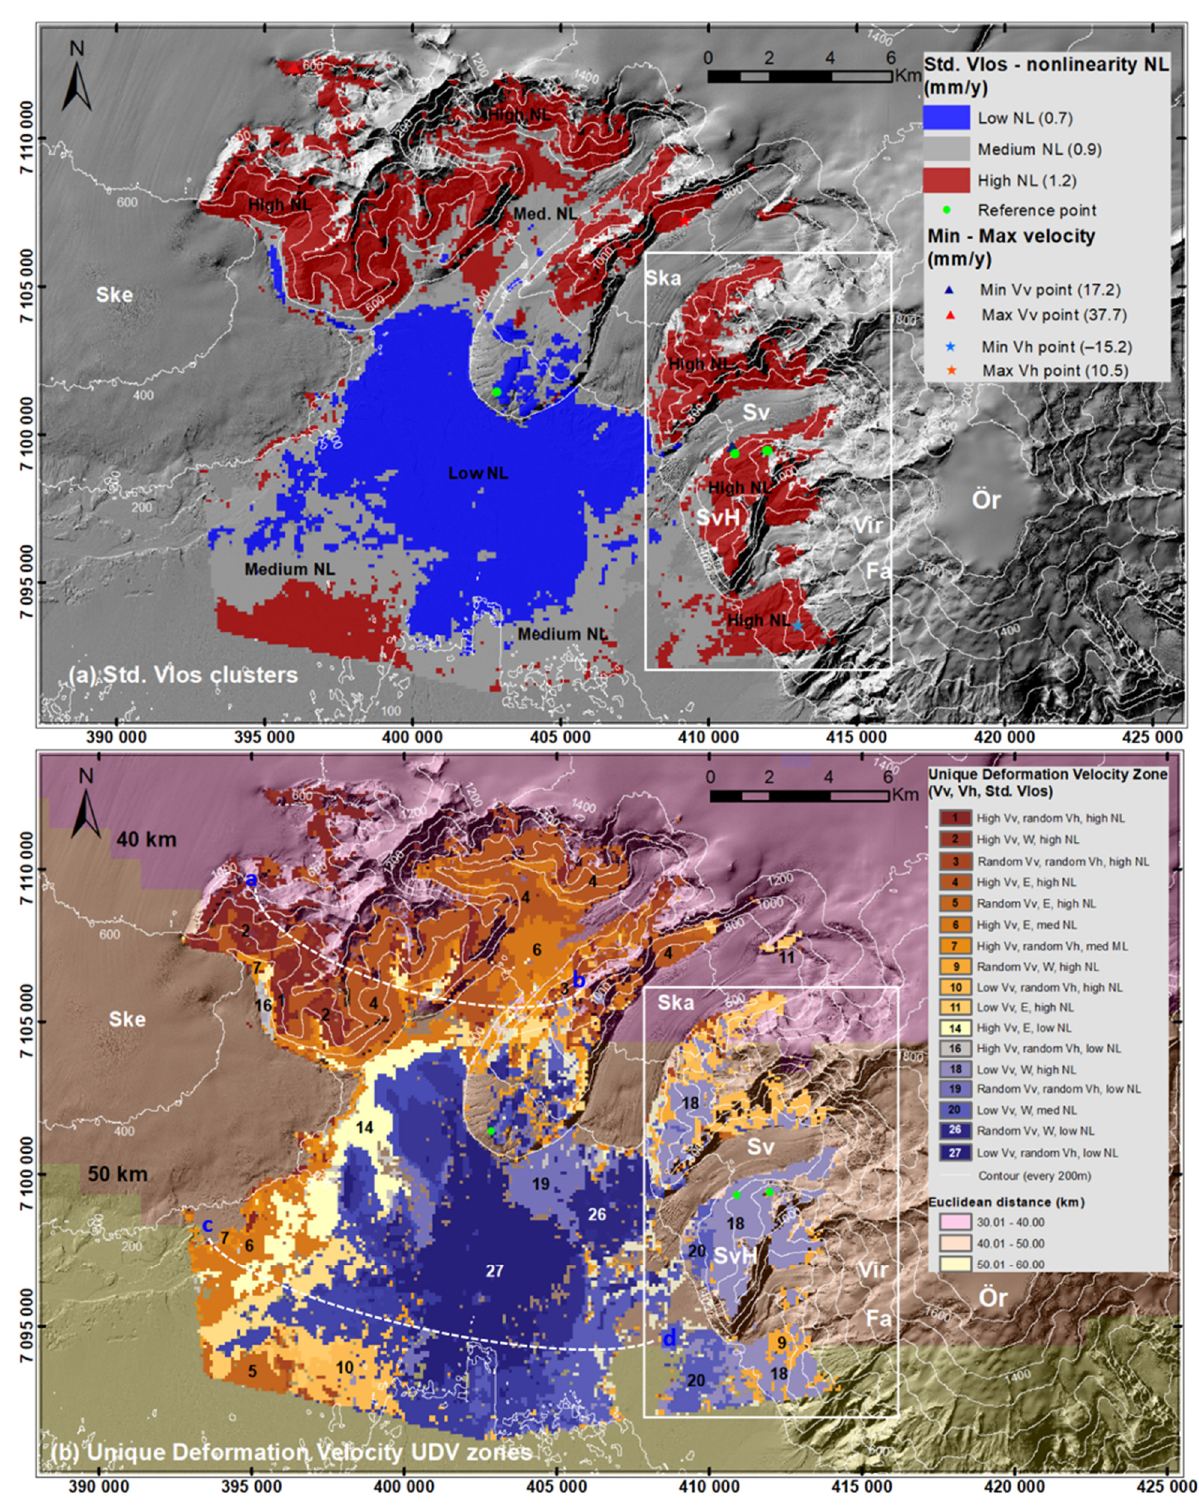
Figure 12. ( a ) Rasterised std . V los cluster as a result of HSA used to infer for surface-movement nonlinearity. PS points with estimated min and max 2D velocities are indicated; ( b ) twenty-seven detailed UDV zones derived based on the combined spatial analysis of three PS-based parameters ( V v , V h and std . V los ) with the conceptual Euclidean distance measured approximately from the centre of Vatnajökull in the background. Our result shows that the Svínafellsheiði (SvH) slope and parts of the slopes located north and south of SvH (indicated by the white rectangle) are characterised by